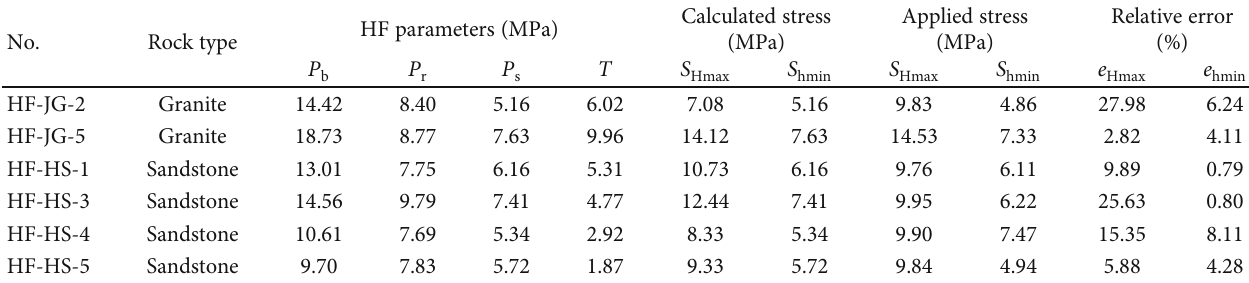
Table 3: Summary of the experimental stress measurement data and the results based on equations (2) and (3).